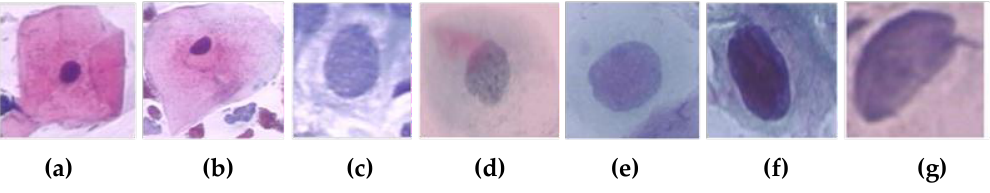
Figure 1. A single cell cervical smear image: ( a ) superficial squamous, ( b ) intermediate squamous, ( c ) columnar, ( d ) mild dysplasia, ( e ) moderate dysplasia, ( f ) severe dysplasia, ( g ) carcinoma in situ [9–11].